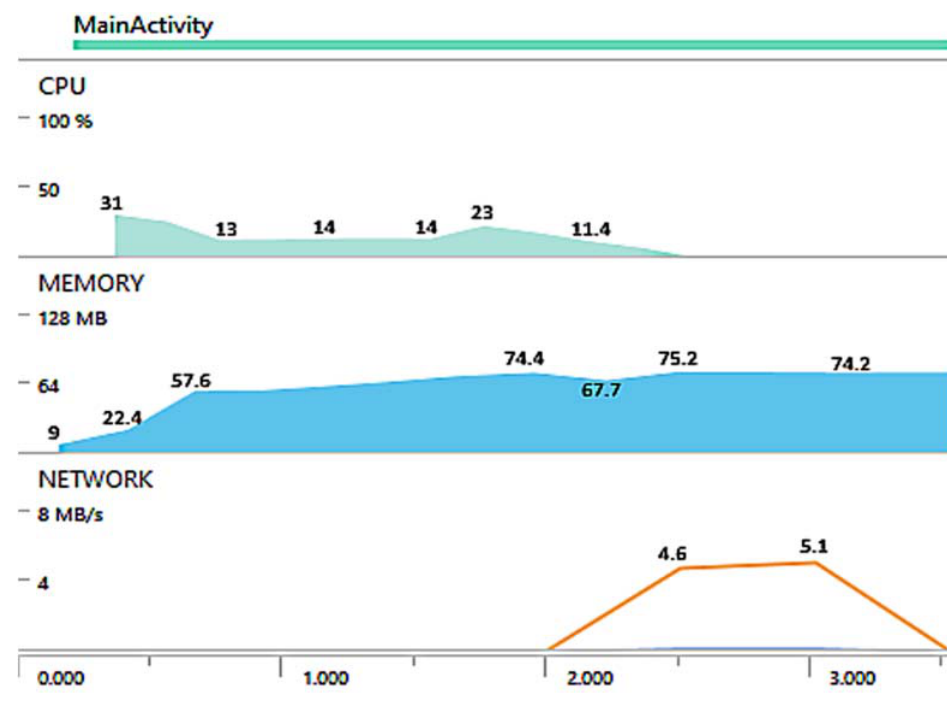
Figure 6. Single file uploads of 2.5 MB.